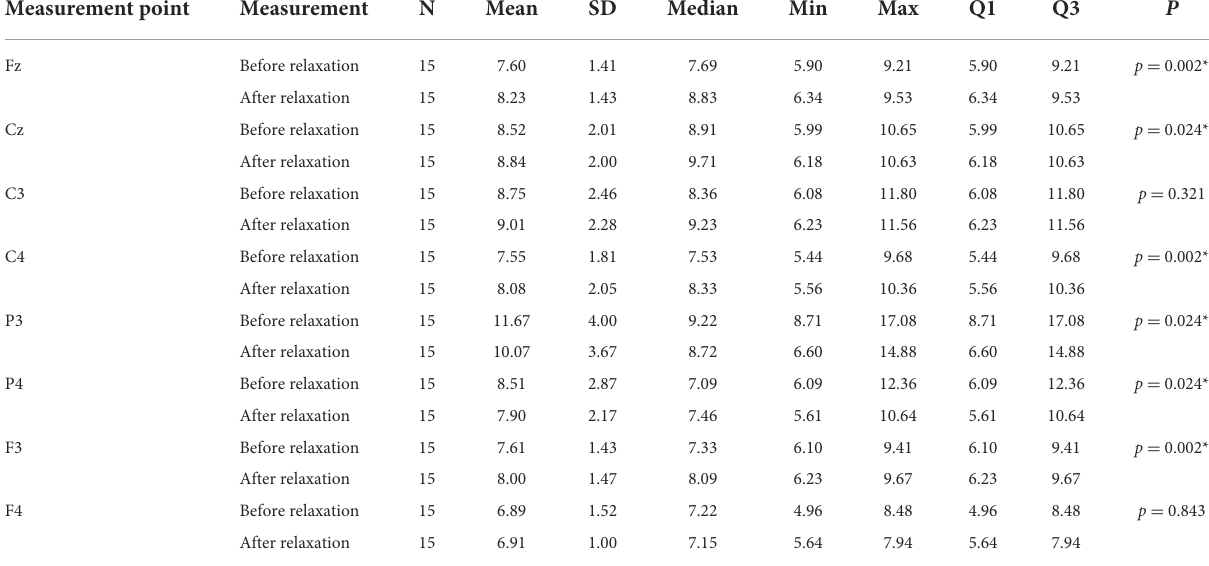
TABLE 4 Comparison of Beta 1 wave amplitudes before the SKY course (first day) and after the whole SKY course (third day) with eyes closed. Measurement